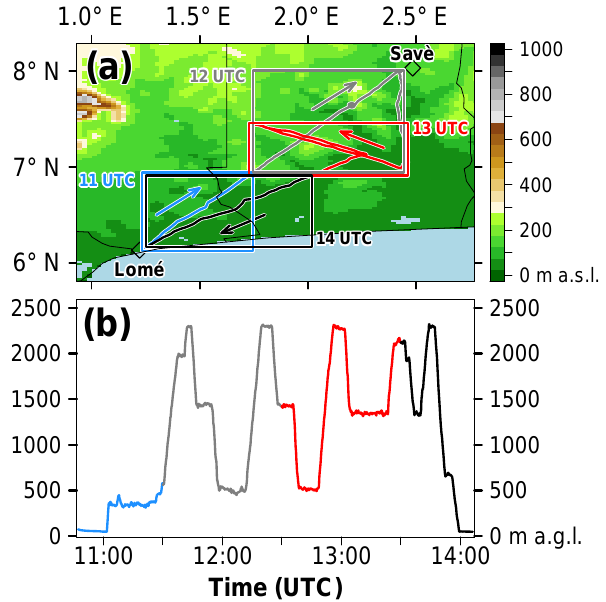
Figure 3. Flight track of the Twin Otter aircraft on 3 July 2016 be- tween 10:47 and 14:06UTC (flight number TO-02) in the (a) hor- izontal and (b) vertical dimension (ma.g.l.). In (a) the topography (ma.s.l.) is added. The flight track in (a) and (b) is separated into hourly time steps for subsequent collocation with hourly model data from COSMO-ART, highlighted in blue (10:47–11:30UTC), gray (11:30–12:30UTC), red (12:30–13:30UTC) and black (13:30– 14:06UTC). The rectangles, spanned by the horizontal extension of the hourly flight sections, are used for the selection of model data. Furthermore, the arrows in (a) indicate the flight direction with the takeoff at Lomé, the flight to Savè and the return to Lomé airport. Shortly after 12:00UTC (with a flight altitude of 0.5kma.g.l.) the Twin Otter reached Savè. Note the meridional compression of the map in (a) .